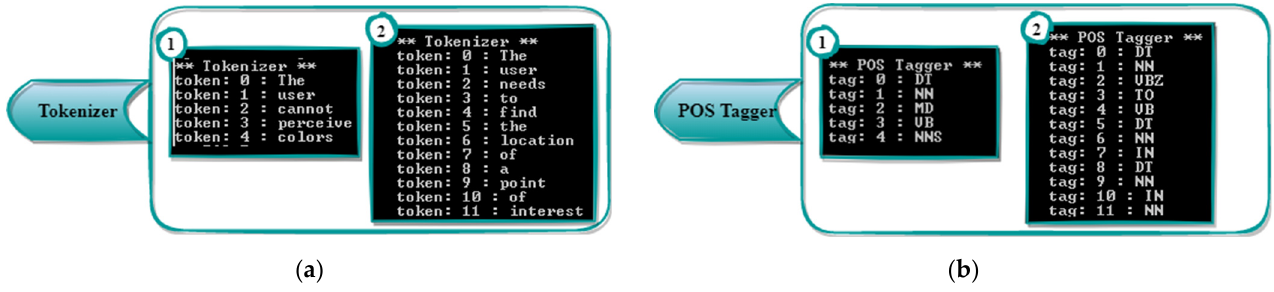
Figure 9. Results for DPS-1: ( a ) tokenizer results; ( b ) POS tagger results.